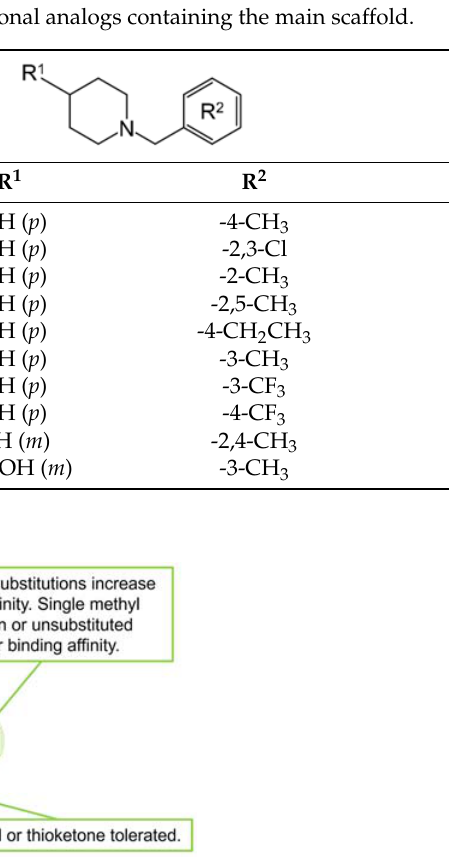
Figure 4. Structure–activity relationships (SAR) based on K D values of analogs determined by SPR.